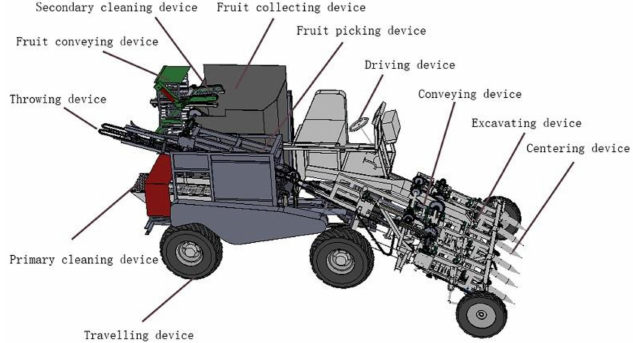
Figure 1. The overall structure of the three-monopoly six-row peanut combine harvester. When the three-monopoly, six-row peanut combine is harvested. The centering device separates the peanut plants to be harvested. In contrast, the gear rotates toward the peanut plants to be harvested. The peanut plants are lifted and gathered into a central position. At the same time, the excavating device breaks the peanut’s main roots and loses the soil under the action of the forward force of the machine. With the cooperation of the centering and excavating devices, the peanut plants move backward according to inertia into